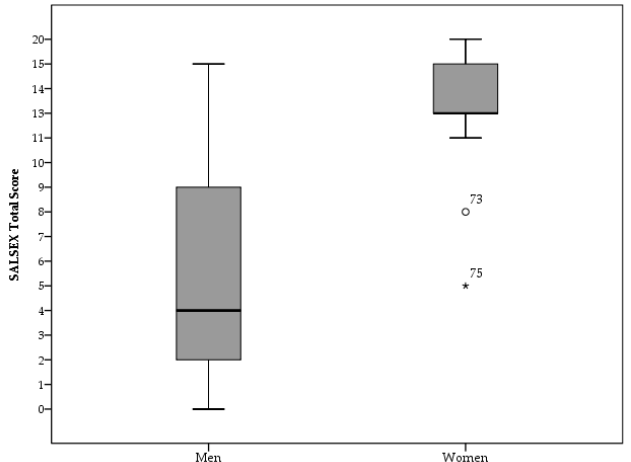
Figure A1. Difference between men and women in SALSEX total score. The ° symbol represents an outlier and the * symbol corresponds to extreme value.